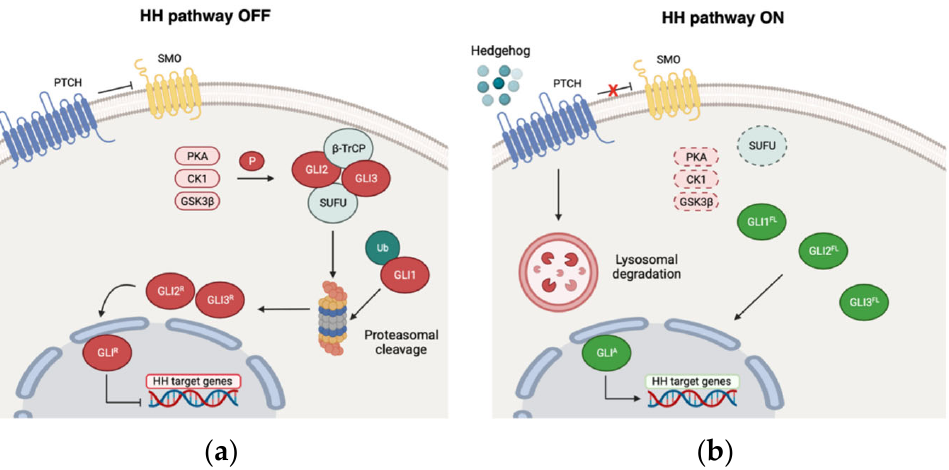
Figure 1. The canonical Hedgehog-GLI signaling. In the absence of any Hedgehog ligand stimulation ( a ), the transmembrane receptor PTCH1 inhibits the G-coupled protein Smoothened (SMO). GLI transcription factors are phosphorylated by PKA, CK1, and GSK3 β and are thus recognized by SuFu, which sequesters them outside the nucleus. Herein, GLI2 and GLI3 are processed into the repressive forms, which hinder the transcription of Hedgehog target genes. GLI1 is degraded through the ubiquitin-proteasome system (UPS). The presence of a Hedgehog ligand that specifically binds PTCH1 ( b ) releases the inhibitory regulation of SMO. Accordingly, SMO initiates an intracellular cascade, which terminates with the translocation of the GLI as active forms into the nucleus, promoting the transcription of Hedgehog target genes.